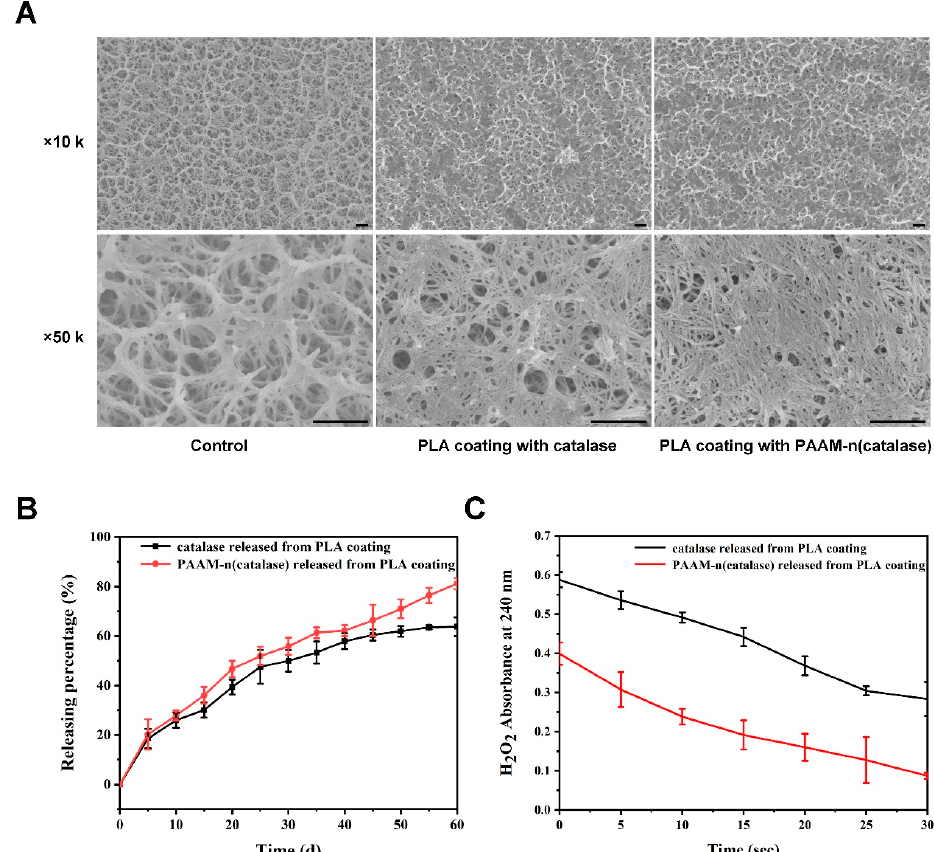
Figure 5. ( A ) The representative SEM images of a titanium dioxide plate and a PLA-coated titanium dioxide plate; the bar was 500 nm; ( B ) the release profiles of native catalase and PAAM-n(catalase) from the PLA coating; ( C ) the activity of released catalase was tested by the degradation kinetics of H 2 O 2